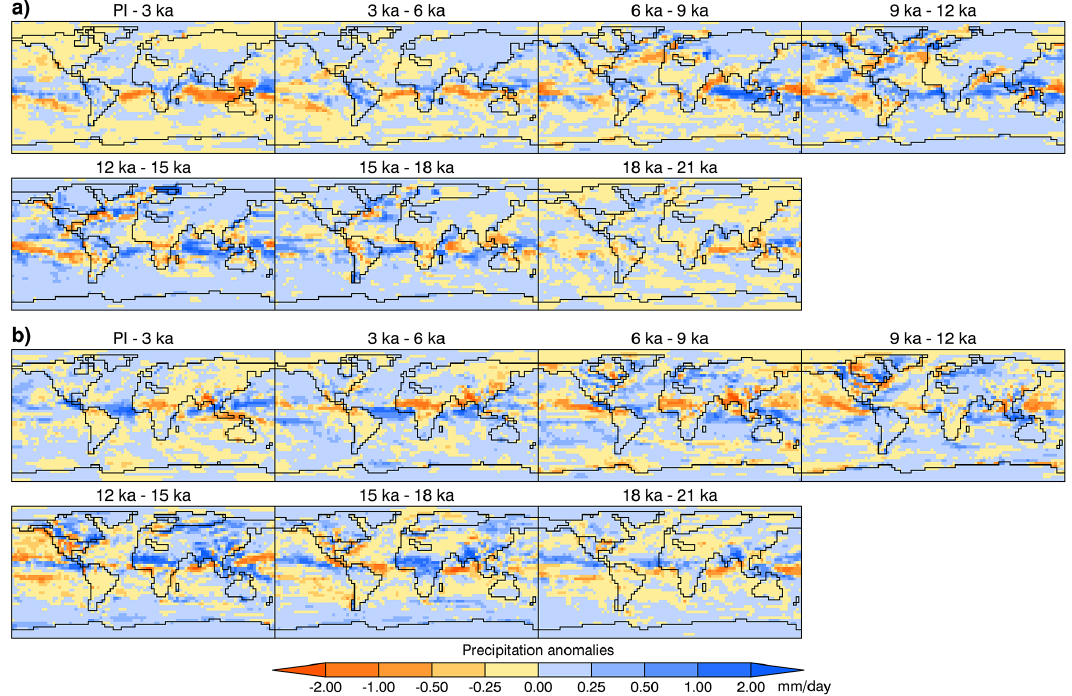
Figure 9. Simulated seasonal average precipitation changes between consecutive time slices. (a) December, January, and February and (b) June, July, and